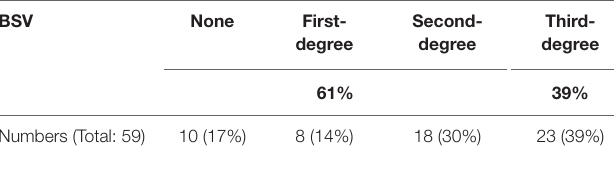
TABLE 2 | BSV grading in IXT